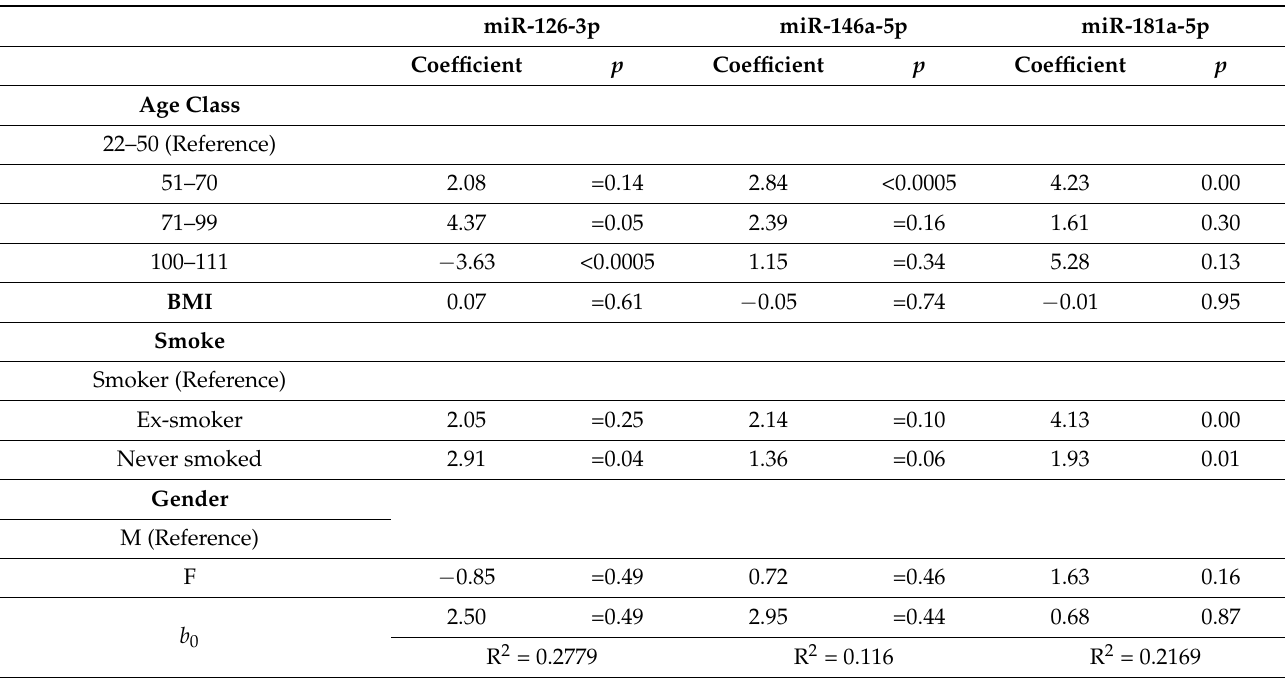
Table 3. Coefficients and significance estimates of other miRNAs.